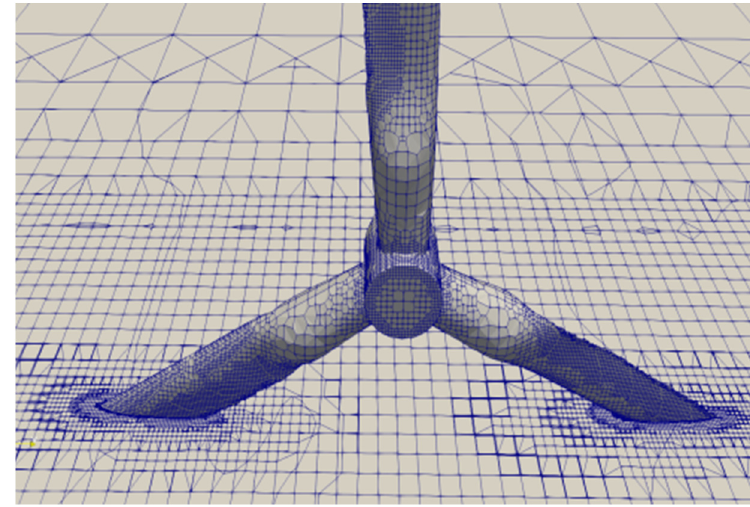
Figure 3. Blade surface and surrounding grid.